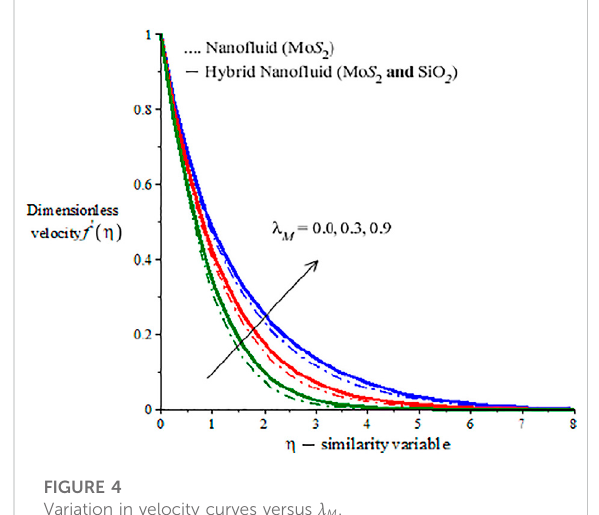
FIGURE 4 Variation in velocity curves versus λ M